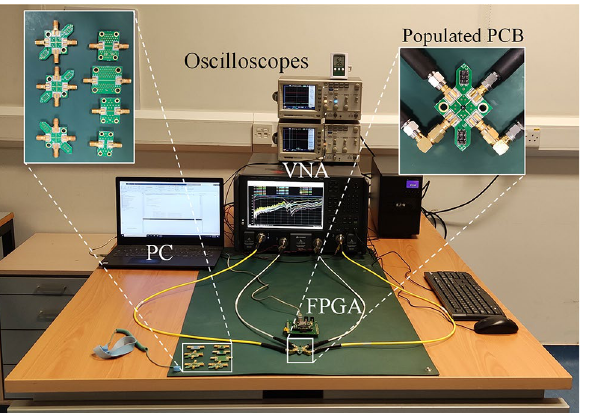
Figure 3. Loading element measurement setup. The PC on the left side of the image, calculates and sends the configuration settings to the populated PCB, which includes the ASIC under test, through an FPGA interface board. To extract the RF characteristics of the chip, as shown on the populated board in the top right inset, the de-embedding boards, shown in the top left inset, are used to characterize and eliminate the effects of all lines leading up to the chip’s solder bumps. The S-parameters are captured on the 4-port Vector Network Analyzer (VNA) and afterwards the real and imaginary part of the impedance is